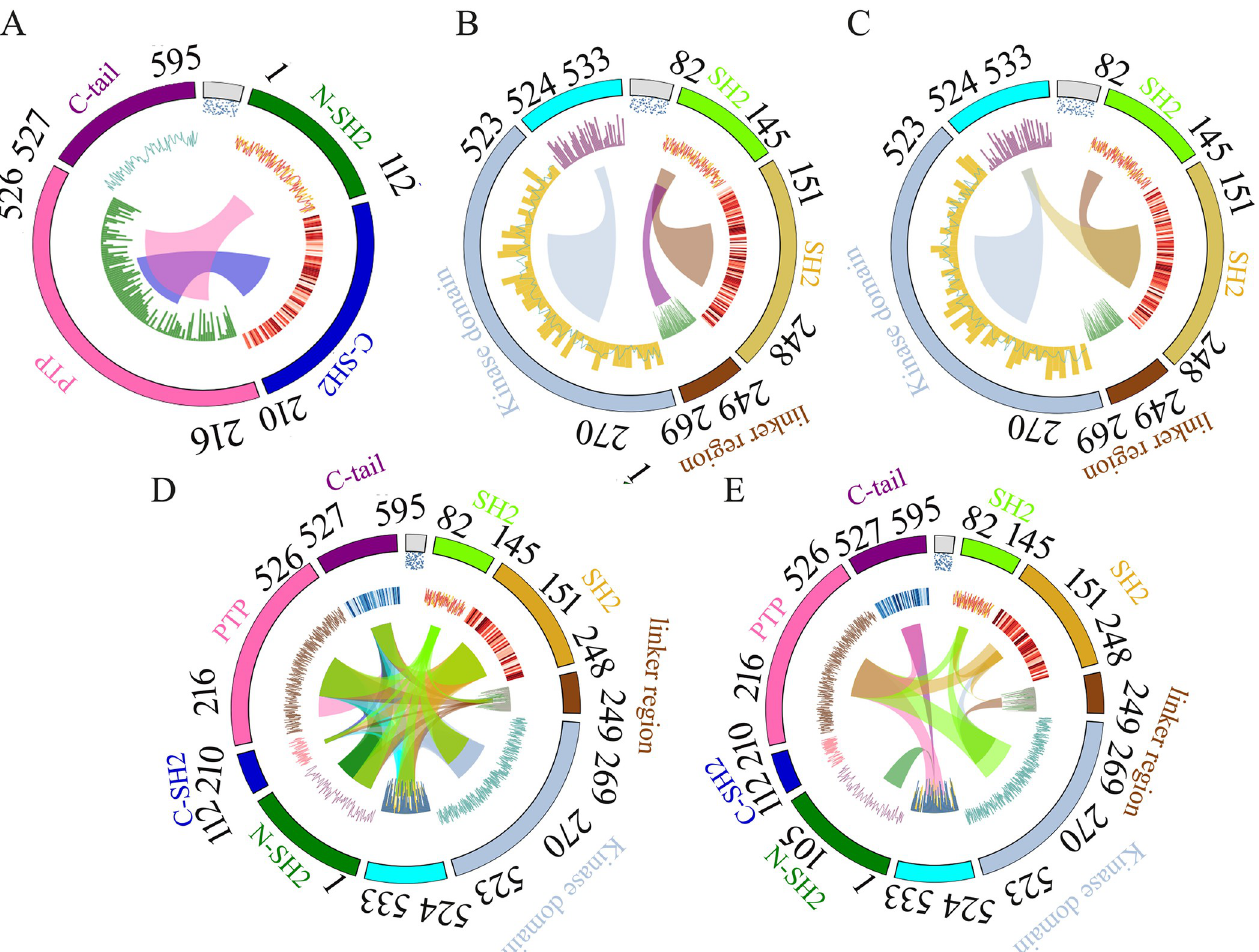
Fig 4. Circos plots with > 70% cross-correlation value. (A) SHP-1(B) c-Src open , (C) c-Src close , (D) c-Src open - SHP-1, and (E) c-Src close -SHP-1. Src domains are represented in different colors: SH3 domain (light green), SH2 domain (orange), linker (brown), kinase domain (gray), and C-terminal tail (cyan). SHP-1 domains are indicated as follows: N-SH2 (green), C-SH2 (blue), PTP (pink), and C-terminal tail (purple).